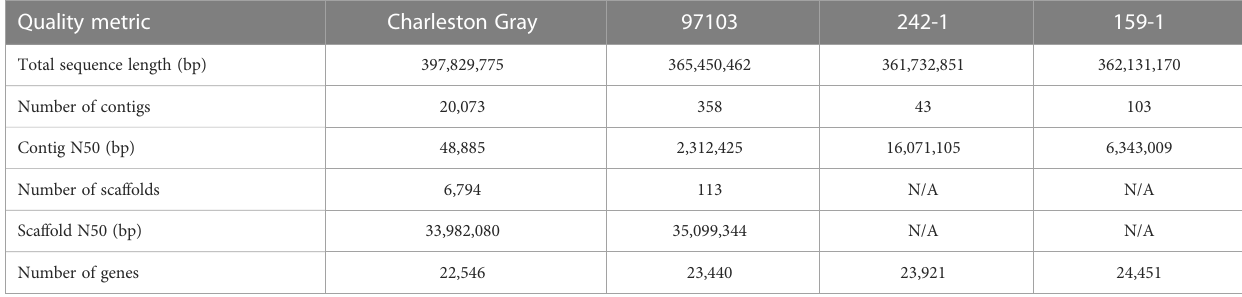
TABLE 1 Comparison of the two assembled genomes (242-1 and 159-1) with two reference watermelon genomes (Charleston Gray and 97103). Quality